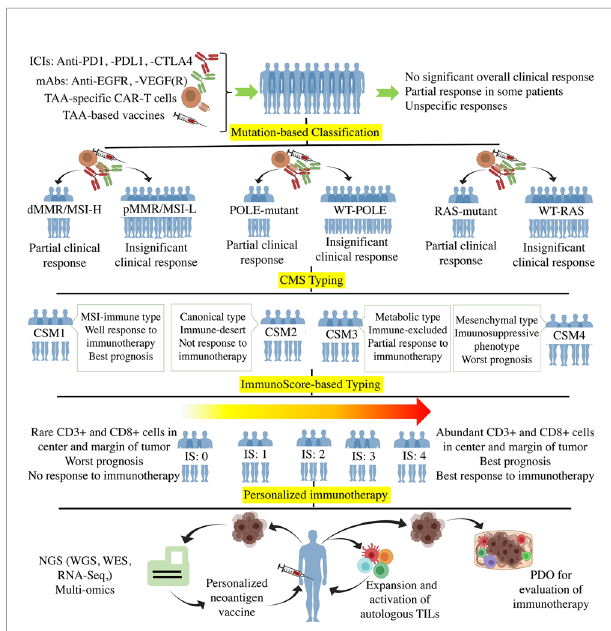
FIGURE 1 | The Process of personalized immunotherapy in CRC. Off-the- shelf immunotherapy such as ICIs, mAbs (anti-EGFR, -VEGF(R)), TAA-speci fi c CAR-T cells, and TAA-base cancer vaccines resulted in tumor regression and stable disease in some patients. However, such immunotherapy did not achieve signi fi cant overall clinical responses when used in unclassi fi ed CRC patients. The mutation-based classi fi cations according to MMR, POLE, and RAS genes showed that the mutant subtypes are more responsive to immunotherapy. CMS typing more clari fi ed the CRC classi fi cation using molecular differences. Regarding the fact that immunotherapy is the method of choice for those tumors with high in fi ltration of immune cells, the immune-based classi fi cation such as immunoscore (Ranged between 0-4) grouped the patients based on the tumor in fi ltration of immune cells. Ultimately, Personalized immunotherapy tried to classify each patient as an independent group in which the individualized neoantigens is determined through the hi-tech NGS and multi-omics to optimize and personalize the cancer vaccines. Besides, autologous ACT and PDO-based prediction of the immunotherapy responses are the other approaches towards personalized immunotherapy. ICI, Immune-checkpoint inhibitor; PD1, Programmed cell death protein 1; PDL1, PD ligand 1; CTLA4, cytotoxic T-lymphocyte-associated protein 4; TAA, Tumor-associated antigen; EGFR, Epidermal growth factor receptor; VEGFR, Vascular- endothelial growth factor receptor; CAR-T cell, Chimeric antigen receptor T cell; d/pMMR, De fi cient/pro fi cient miss match repair; MSI-H/L, Microsatellite instability high/low; POLE, DNA polymerase epsilon; CMS, Consensus molecular subgroup; NGS, Next-generation sequencing; WES, Whole-exome sequencing; RNA-Seq, RNA sequencing; TIL, Tumor-in fi ltrating lymphocyte; PDO, Patient-derived